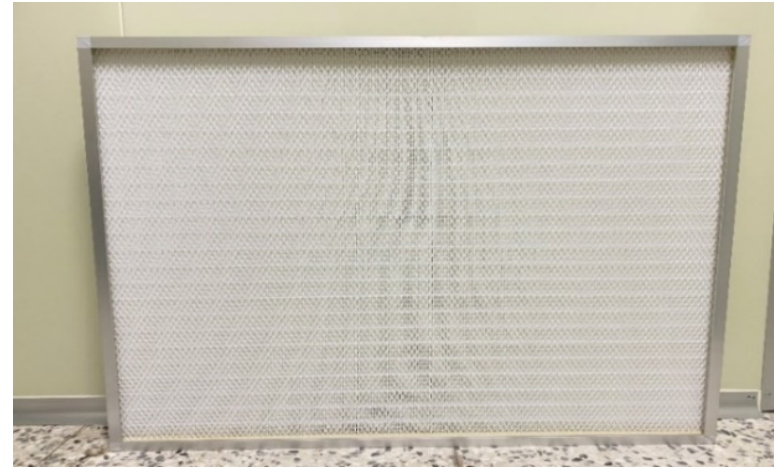
Figure 14. Chemical filter screen.